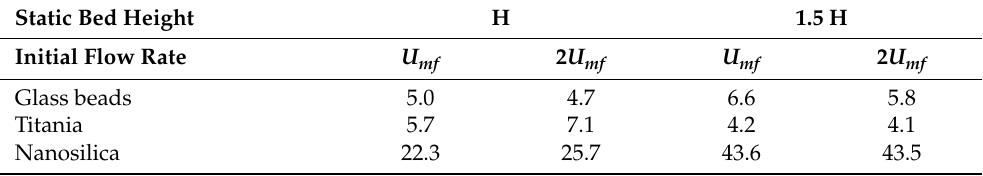
Table 2. Total bed collapse time (in seconds) evaluated using global pressure drop transients. Static Bed Height